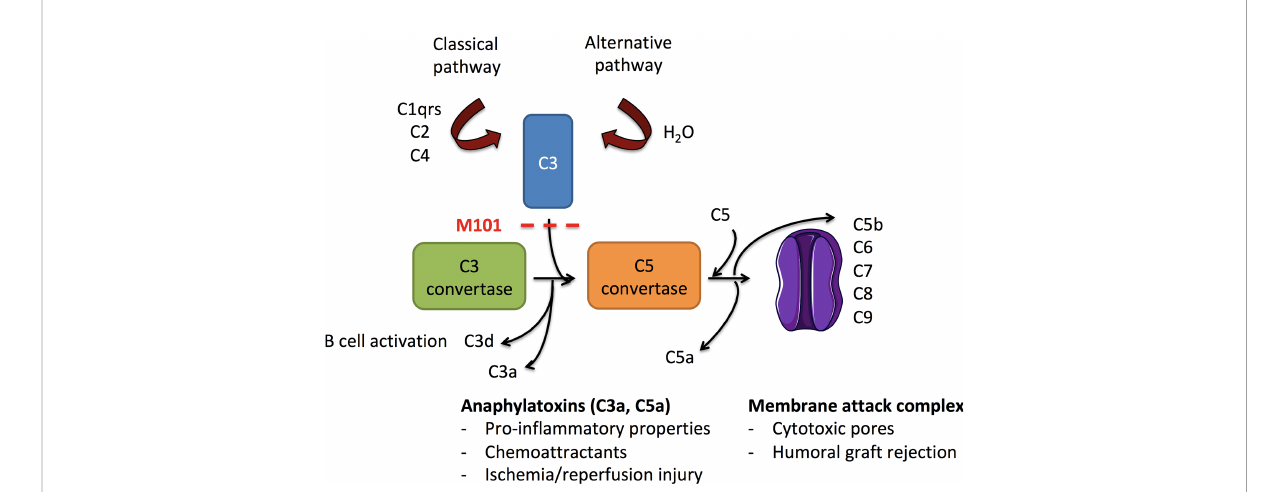
FIGURE 1 Schematic overview of complement activation in ischemia/reperfusion injury and allograft rejection. Activated following immunoglobulin binding to its antigen (classical pathway) or after the continuous hydrolysis of C3 in an aqueous environment (alternative pathway), both complement pathways lead to the formation of C3 convertases (C4bC2a and C3bBb, respectively). Downstream, C3 convertases cleave C3 into C3a (anaphylatoxin) and C3b. C3b ampli fi es the complement activation through formation of new C3 convertases and contributes to the formation of C5 convertases (C4bC2aC3b and C3bBbC3b). C3 convertase is further inhibited by factors I and H that fi nally convert C3b